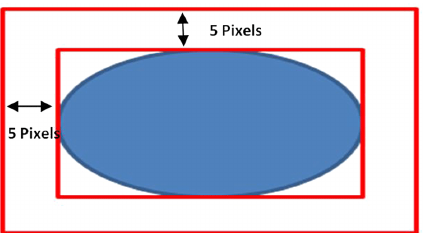
Figure 1. IASI-A foot print (blue) at nadir. The outer red bound- aries indicate the perimeter area where the perimeter threshold is applied. This area is 5 AATSR pixels (5km) wide. The mean radi- ance of AATSR pixels collocated within the blue is compared with the IASI-A representative pixel radiance. Figure 2. Scan angle dependence of the AATSR–IASI bias for